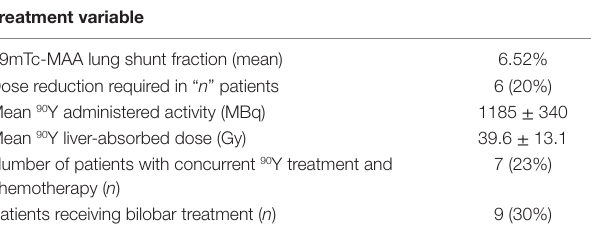
TaBle 2 | sirT treatment details. Treatment